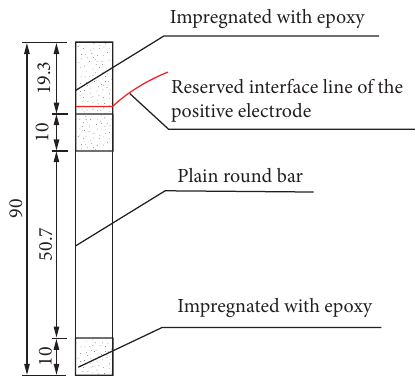
Figure 3: A schematic of the anticorrosion treatment of the steel